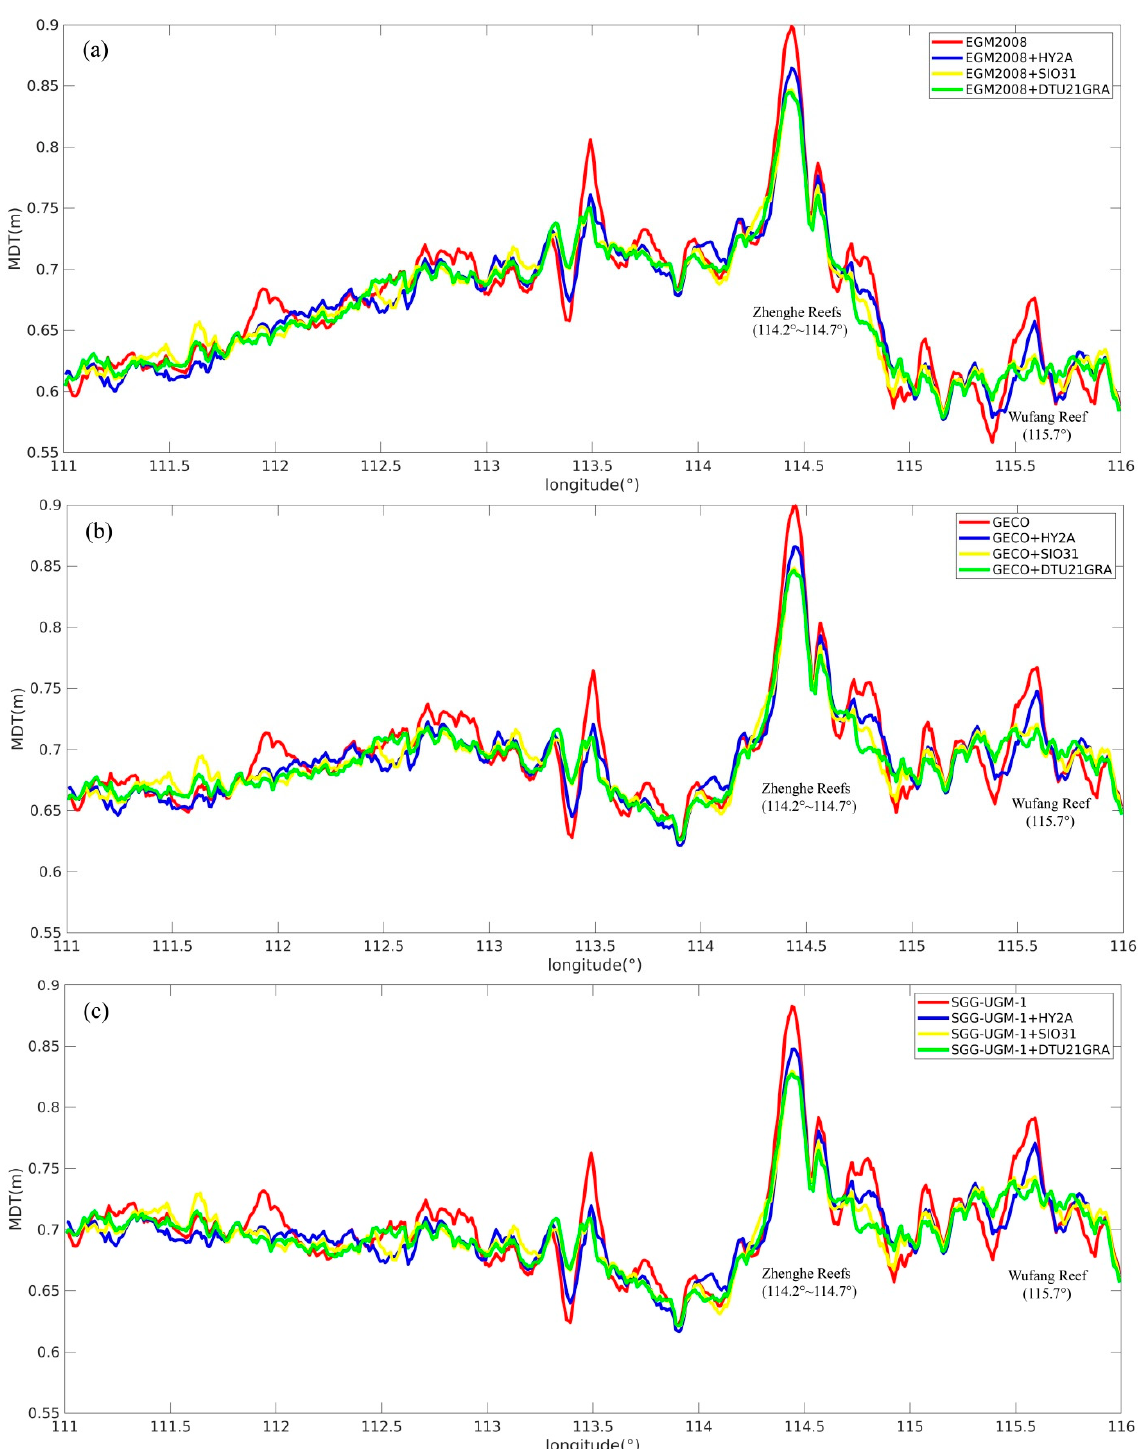
Figure 9. Profiles of the MDTs modeled with ( a ) EGM2008, ( b ) GECO, and ( c ) SGG-UGM-1 based on different altimetric gravity models along latitude 10.4°N.